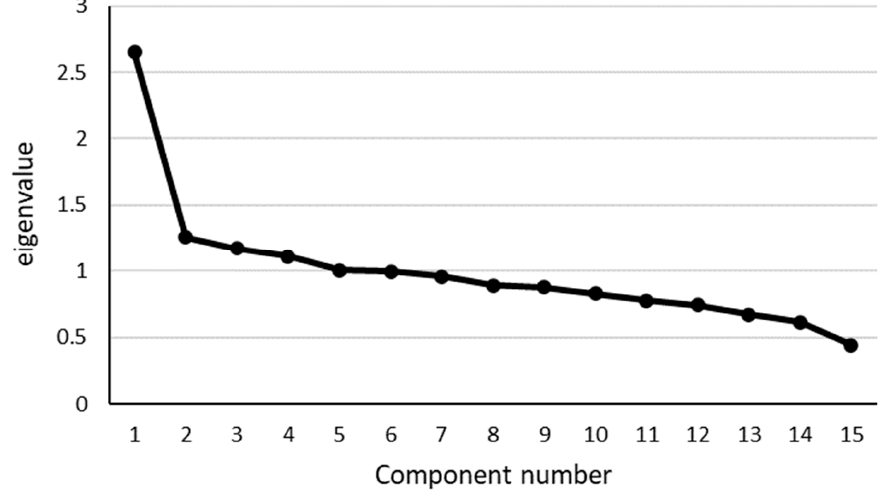
Figure 1. A scree plot of the health assessment questionnaire for old-old adults (15 items) in the EFA. The proportion of variance accounted for by these five factors was 25.1%. The principal factor method was used to identify the factor loadings of each item by setting the number of factors to five. Promax rotation was performed to obtain the factor pattern matrix. Table 4 shows the factor loading of each item after factor rotation, and the estimated communality after factor identification. The factor loadings were interpretable with respect to the items of both Factor 1 (general health assessment: self-rated health status; life satisfaction) and Factor 4 (cognitive function: always asking the same thing; not remembering today’s date). However, the other factors were difficult to interpret because Factor 3 included various aspects, such as oral function, weight loss, and physical function, and Factor 5 included social relationships, nutritional status, and smoking habits. In addition, Factor 2 was difficult to interpret because there was only one item with a factor loading of ≥ 0.4. Although the estimated communality of items Q1 and Q2 were the highest, at 0.72 and 0.40, respectively, the communality of the eight items was approximately 0.2. Specif- ically, the estimated communality of item Q12 “smoking habits“ was the lowest (0.02). These results indicate that the questionnaire with 15 items was not explained by the five factors, and the EFA using 15 items did not extract interpretable factor structures. Table 4. Factor loadings and estimated communality in the EFA using the principal factor method with Promax rotation of the health assessment questionnaire for old-old adults (15 items).